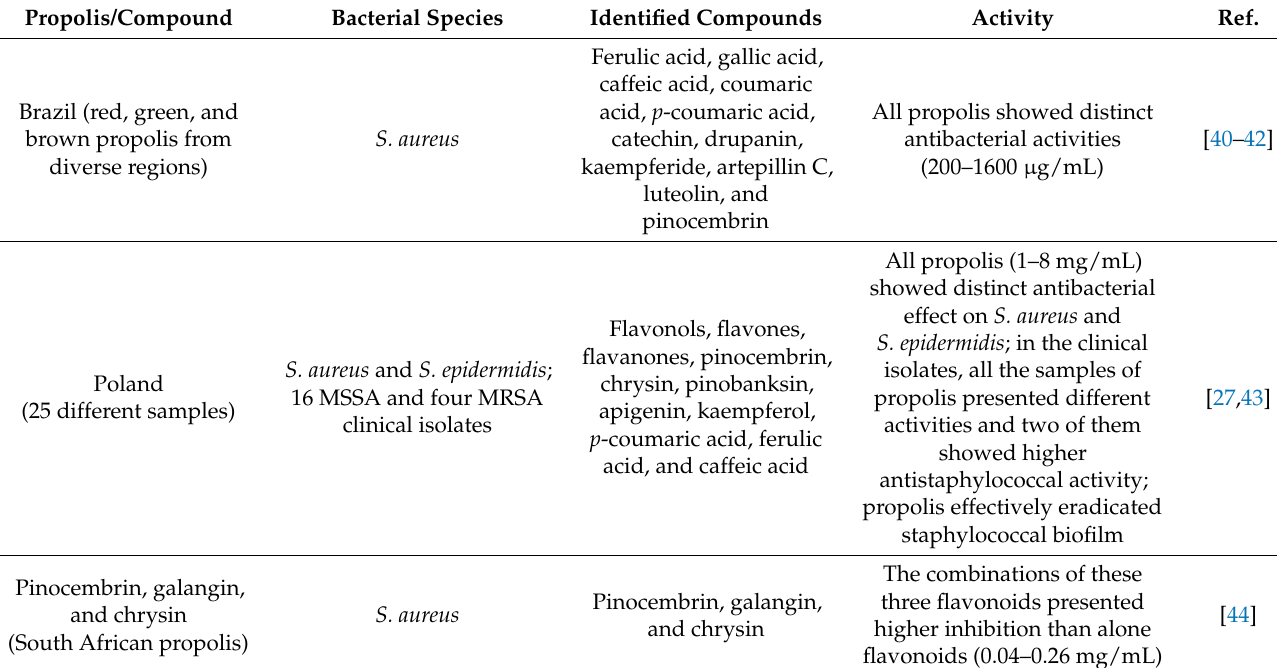
Table 2. Antibacterial effect of diverse propolis and its chemical composition.